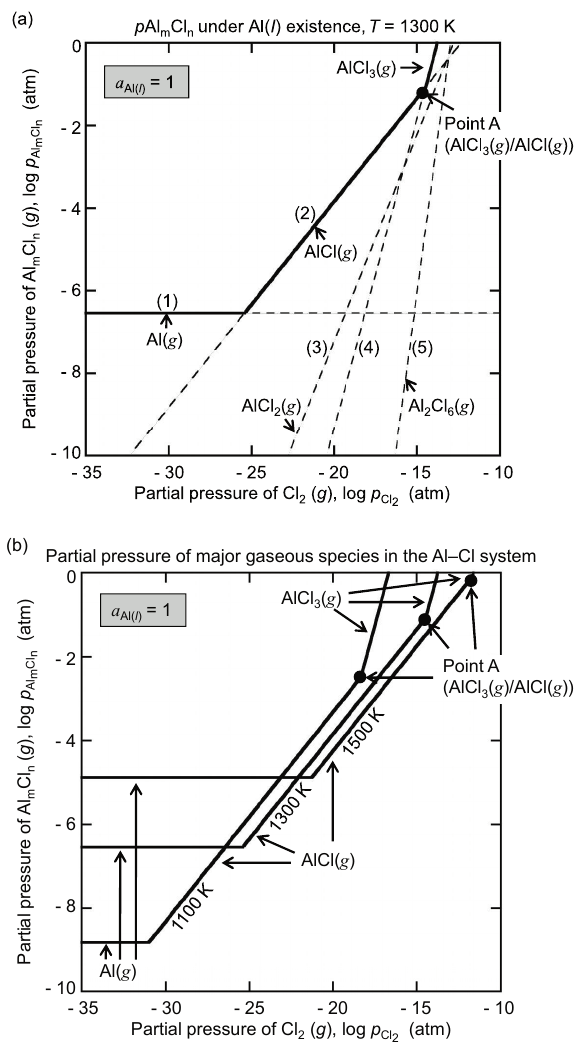
Figure 2. (a) Vapor pressure of Al m Cl n as a function of chlorine partial pressure under existence of Al (l) at 1300 K, and (b) partial pressure of major gaseous species plotted for 1100–1500 K